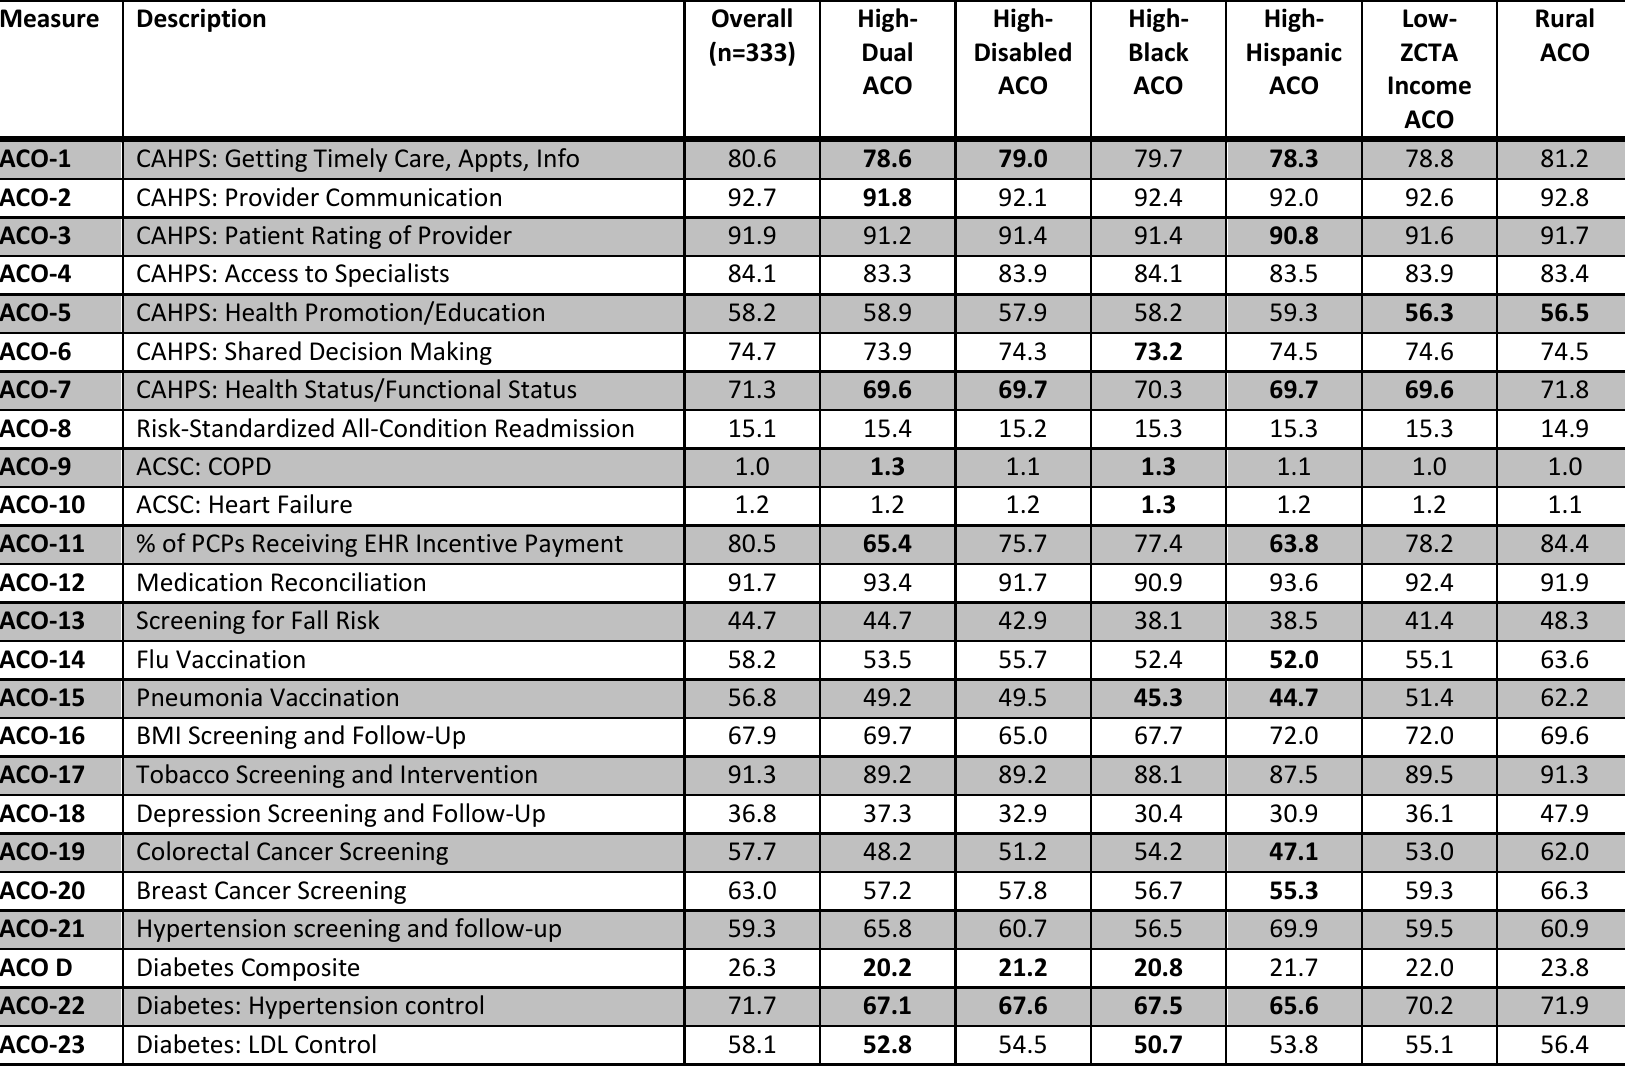
Table 9.8: Median Performance in the Medicare Shared Savings Program by Measure Overall and for ACOs serving beneficiaries with social risk factors